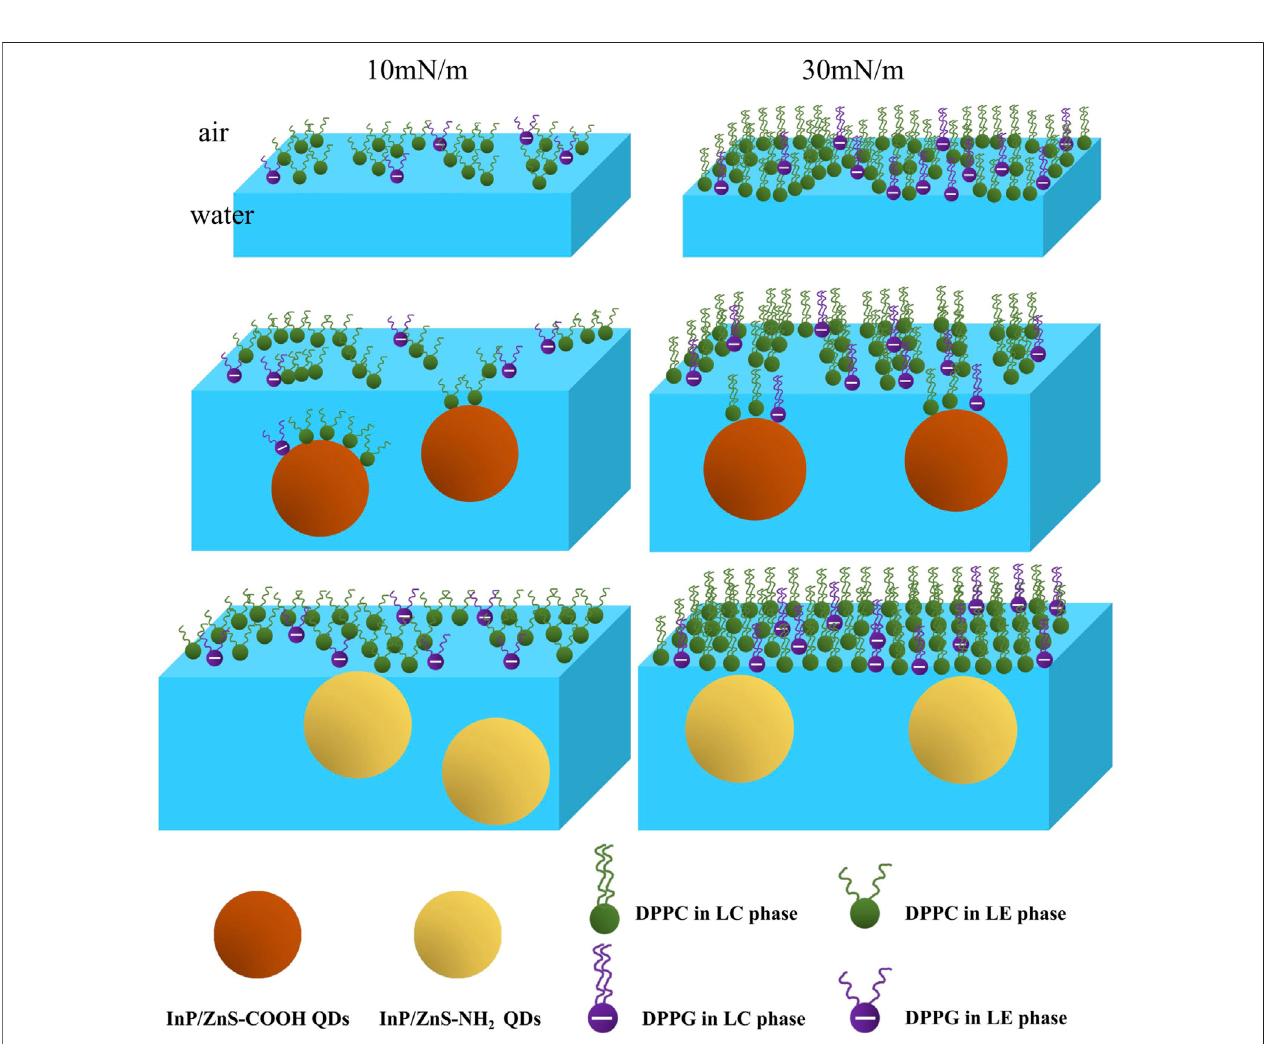
FIGURE 8 | Schematic diagram of the DPPC/DPPG mixed monolayer at 10 mN/m and 30 mN/m in the absence and presence of InP/ZnS-COOH and InP/ ZnS − NH 2